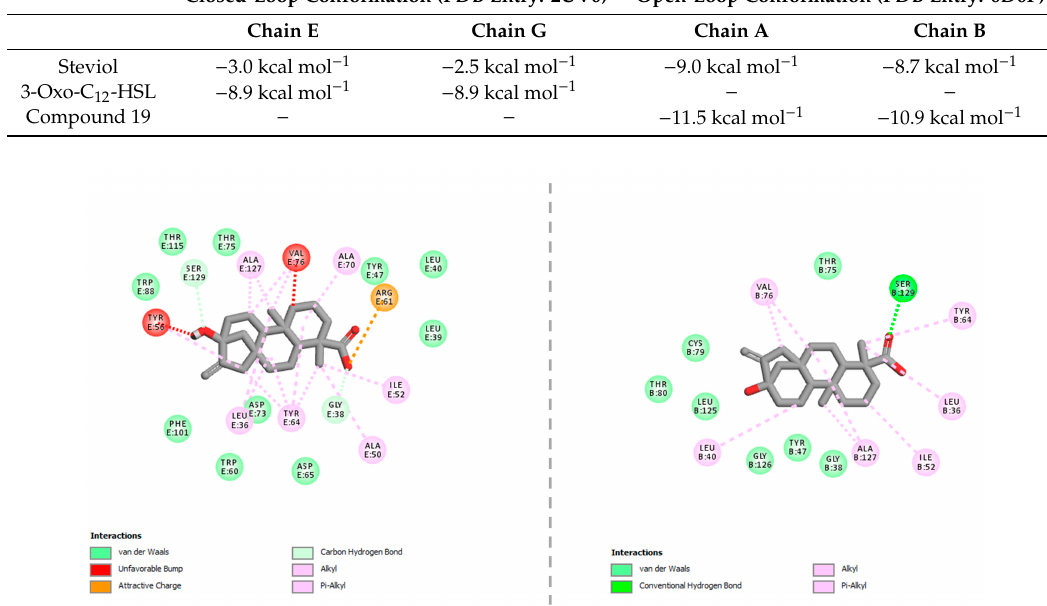
Figure 6. Results of the redocking calculations. Left panel : close-up view of the superposed structures of native (gold) and predicted (silver) 3-oxo-C 12 -HSL in the ligand-binding cavity of LasR in the closed-loop conformation. Right panel : close-up view of the superposed structures of native (gold) and predicted (silver) compound 19 in the ligand-binding cavity of LasR in the open-loop conformation. Images were prepared and rendered using the PyMOL Molecular Graphics System, version 1.8 (Schrödinger LLC, Portland, OR, USA). Table 1. Energetic parameters (docking scores) associated with the binding of steviol at the active site of the LasR-LBD.